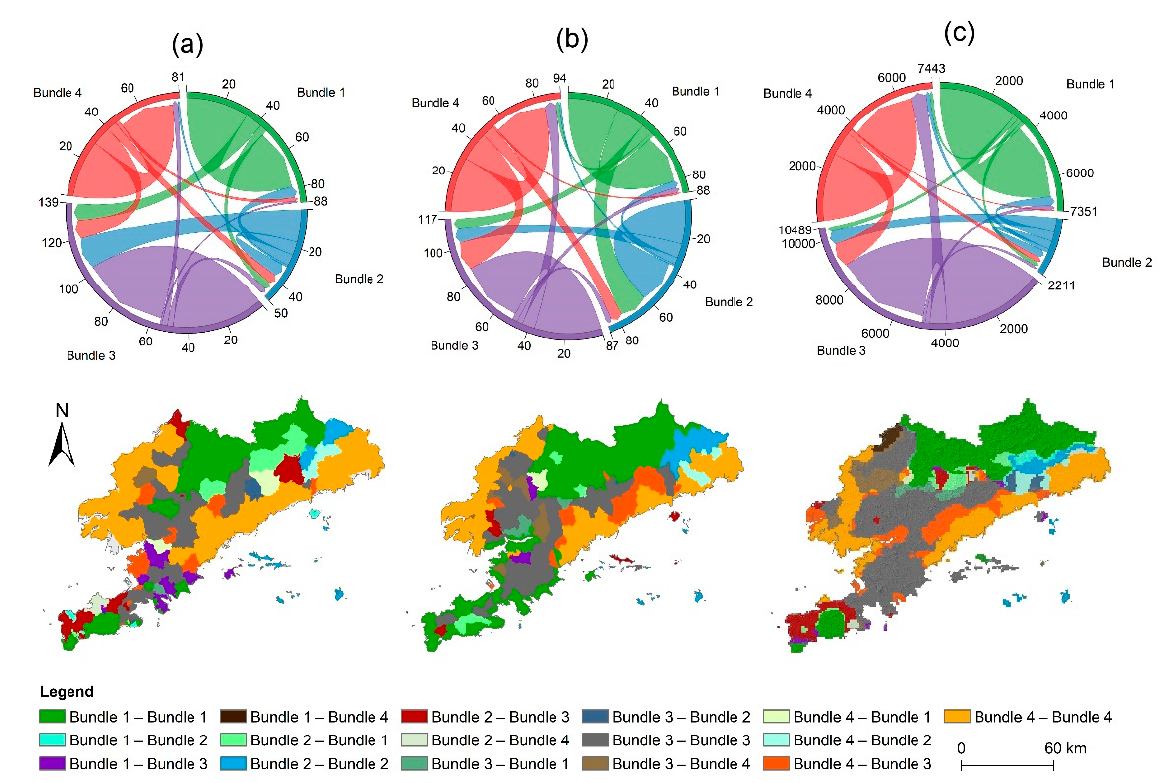
Figure 5. Dynamic changes of ES bundles in Dalian from 2005 to 2015; ( a ) county scale, ( b ) watershed scale, ( c ) 1 km grid scale.